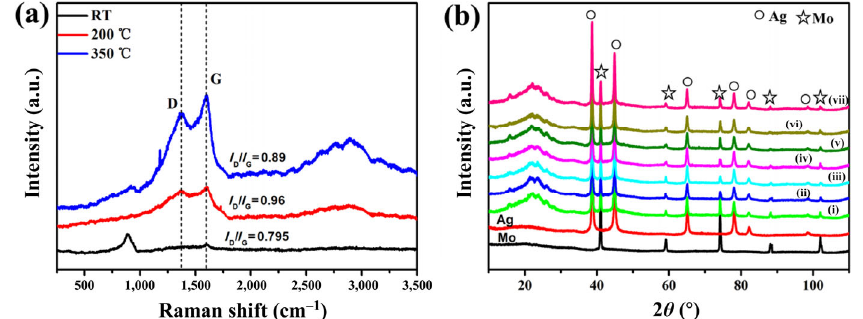
Fig. 7 (a) Raman spectra of steel surface at RT, 200 °C, and 350 °C, (b) XRD patterns of Ag and Mo particles, and worn surface of TPI-1 from RT to 350 °C (i −